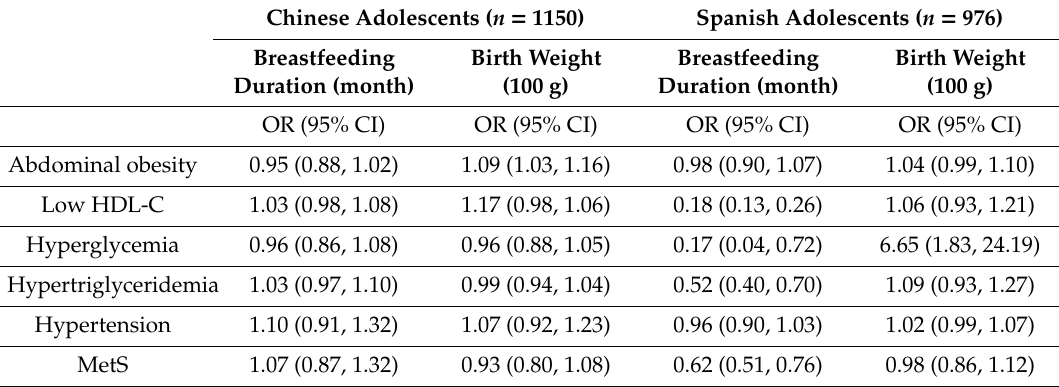
Table 4. Risk of MetS features based on associated factors from multivariable logistic regression in two